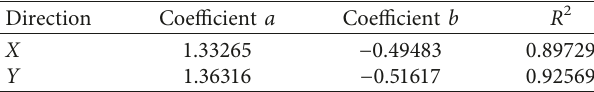
Table 6: Fitting coefficient of E Direction Coefficient